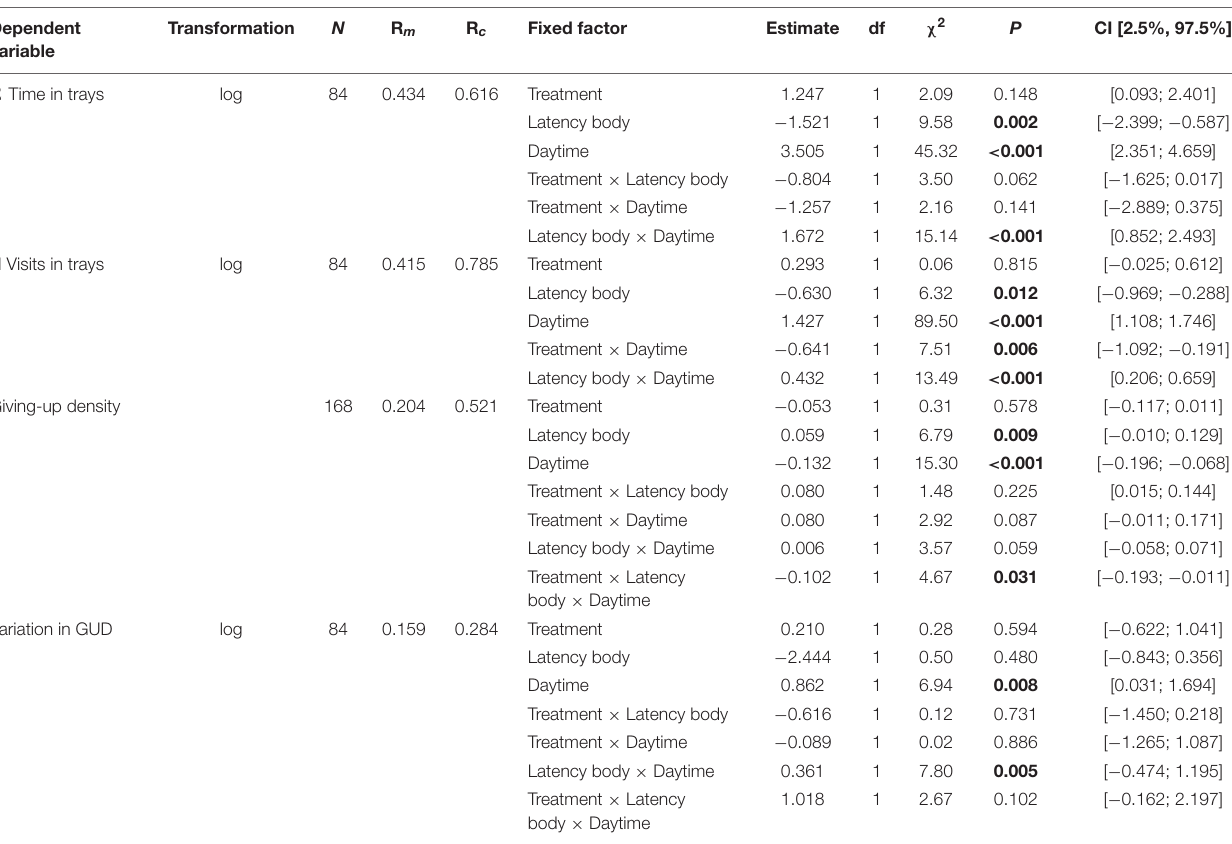
TABLE 2 | Results of Wald chi-square ( χ 2 ) tests for linear mixed models showing the effects of fixed factors on behavioral response variables of bank voles (N Individuals =